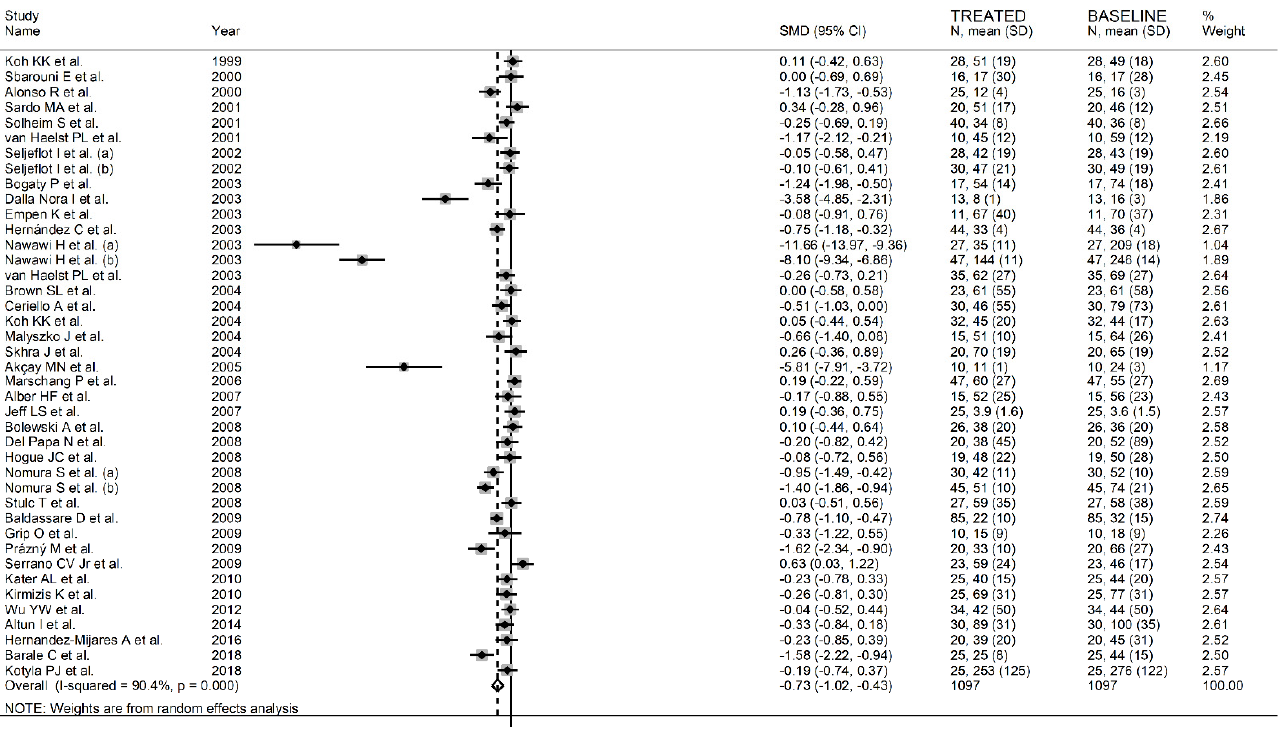
Figure 12. ( A ) Sensitivity analysis of the association between E-Selectin and statin treatment. The influence of individual studies on the overall standardized mean difference (SMD) is shown. The middle vertical axis indicates the overall SMD, and the two vertical axes indicate the 95% confidence intervals (CIs). The hollow circles represent the pooled SMD when the remaining study is omitted from the meta-analysis. The two ends of each broken line represent the 95% CIs. ( B ) Funnel plot of studies investigating E-Selectin concentrations before and after statin treatment.